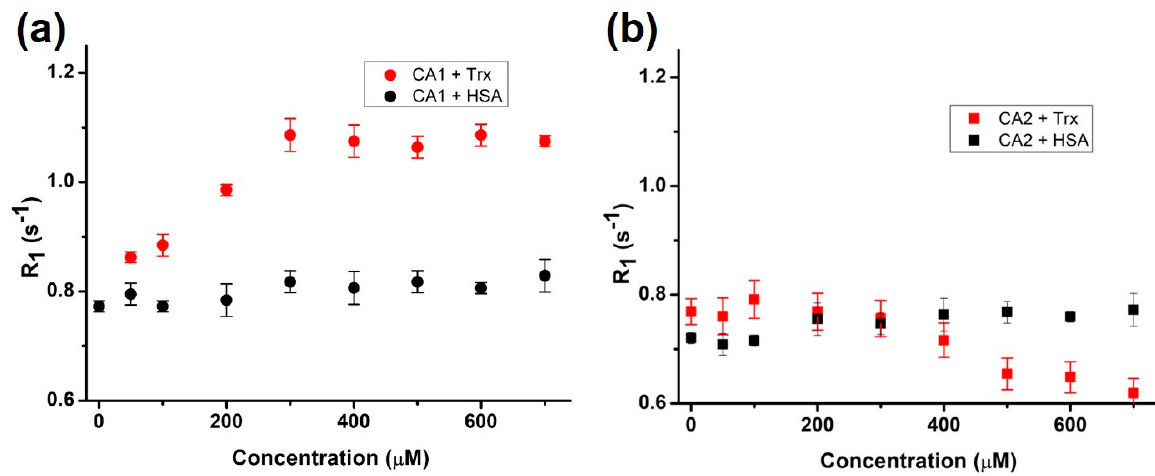
Figure 2. The relaxation rate (R 1 ) of CA1 ( a ) and CA2 ( b ) (100 µM each) in the presence of thioredoxin (Trx) and human serum albumin (HSA) at 60 MHz (measurements were replicated in two independent experiments).